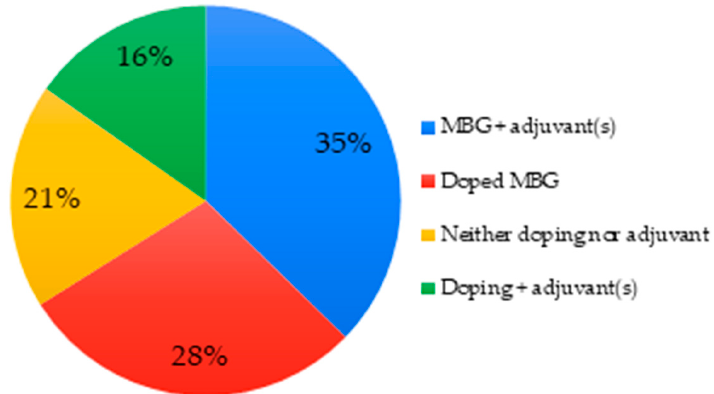
Figure 5. Doping and adjuvants of MBGs used in studied articles.